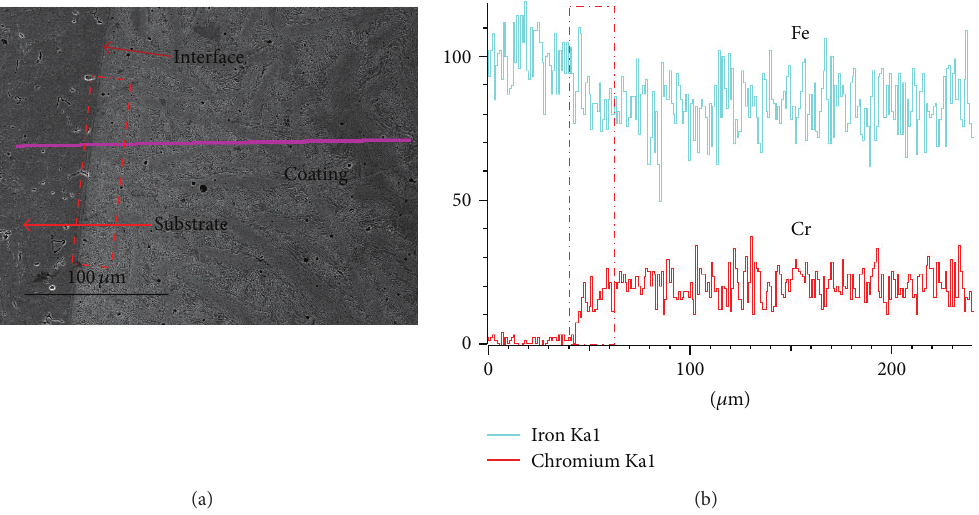
Figure 5: (a) The SEM image of the remelted coating; (b) the EDS analysis along the red line in (a).